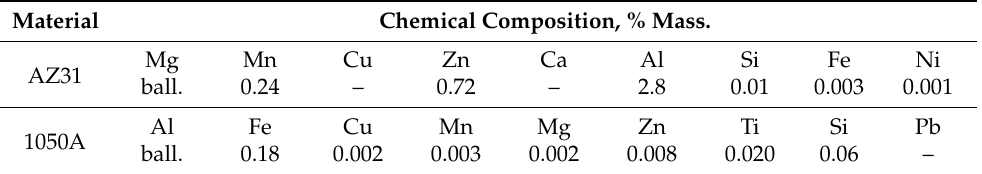
Table 1. Chemical composition of the materials used for the tests [32] (reprinted with kind permission of Springer).